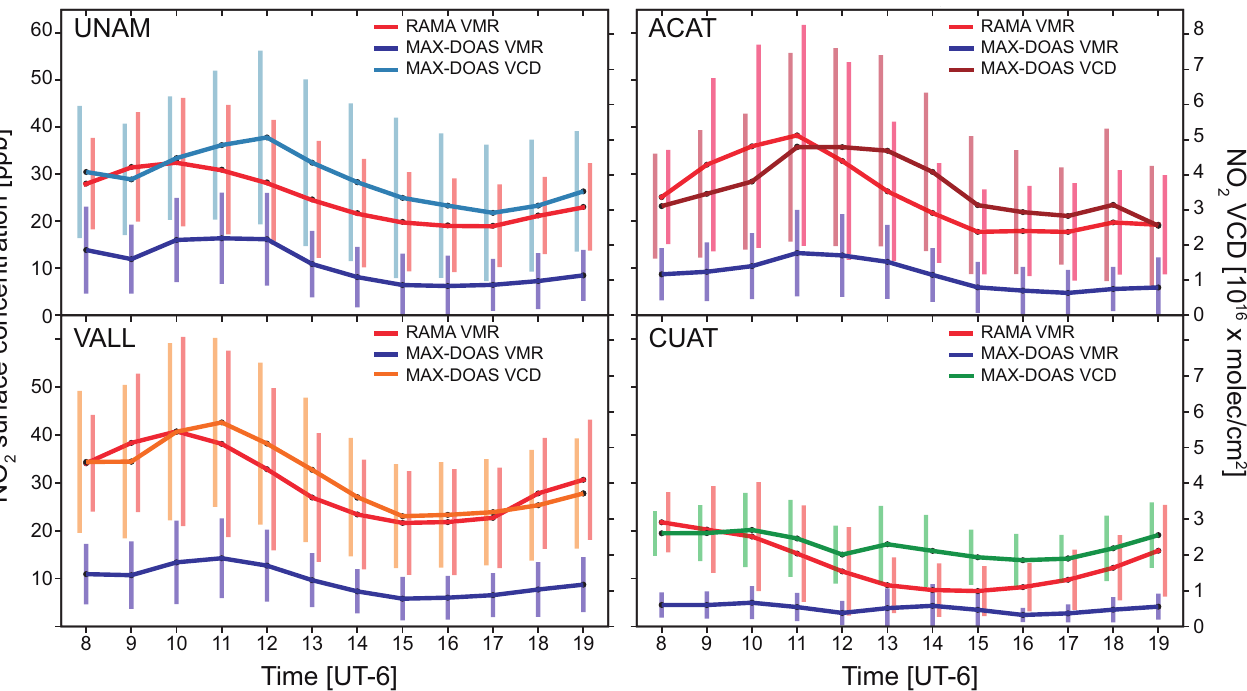
Figure 7. Diurnal cycle over the in situ RAMA network and the superficial column measurements from MAX-DOAS ( Up-left ) UNAM ( Up-right ) Acatlán ( Down-left ) Vallejo and ( Down-right )